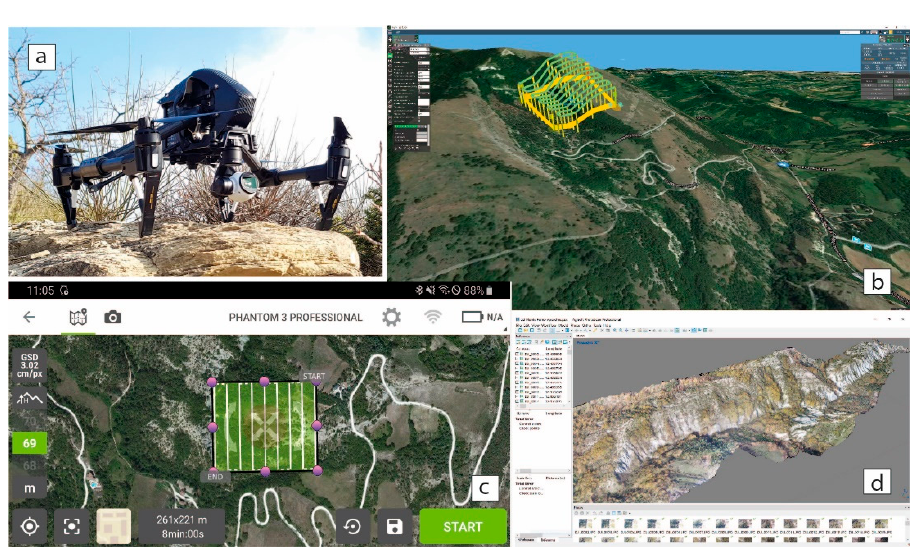
Figure 5. ( a ) Drone DJI Inspire 1 v2.0 equipped with a 12-megapixel camera (CMOS Sony Exmor 1/2.3 sensor); ( b ) UgCS for a three-dimensional (3D) flight plan using Google Earth; ( c ) Pix4D for planning an aerial survey; ( d ) virtual outcrop created with Agisoft Metashape.